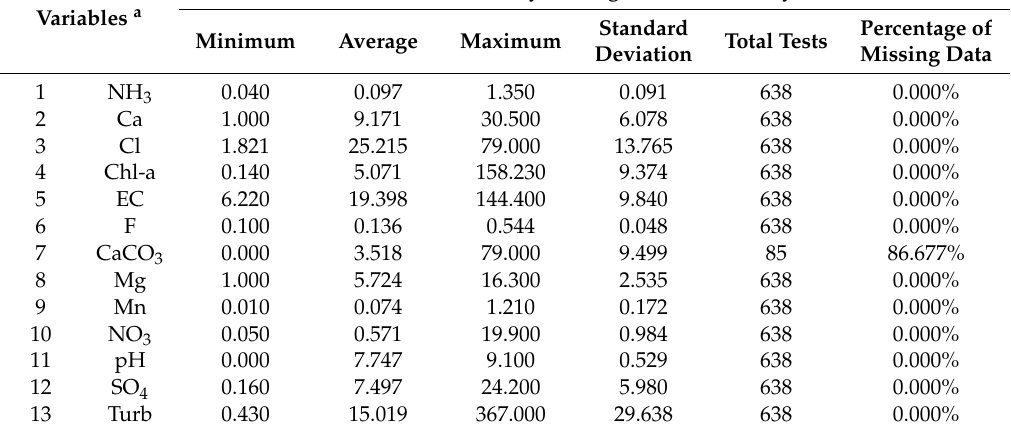
Table 1. Descriptive Statistics for Observed Water Quality Data for Umgeni Water Board Used to Develop the Surrogate Water Quality Index (WQI) Model.